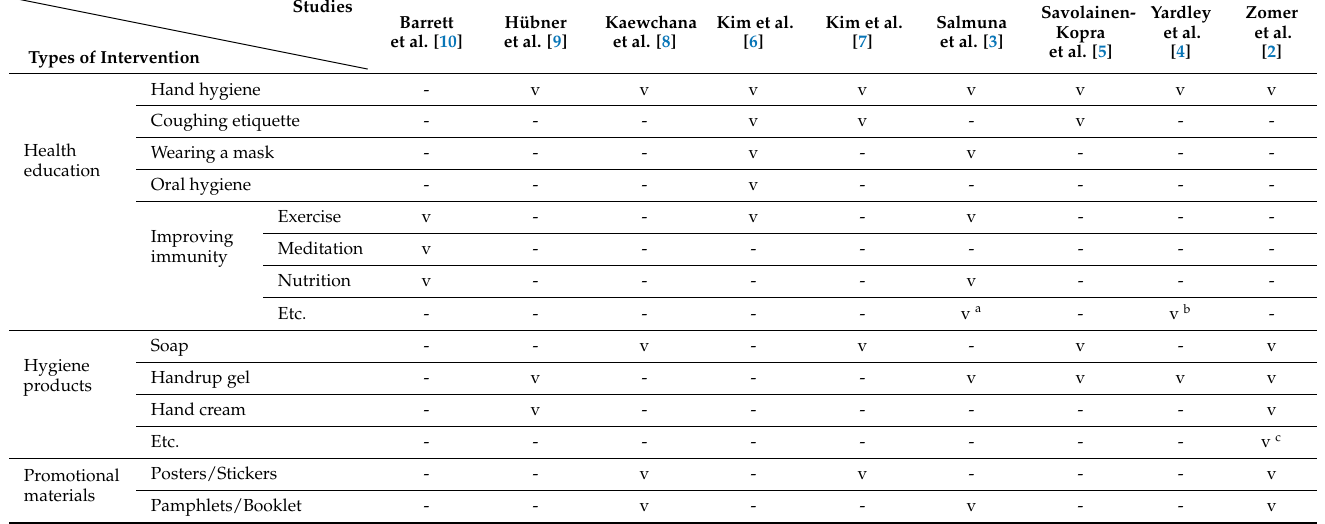
Table 4. Types of intervention in enrolled